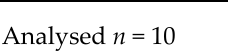
Figure 3. The CONSORT flow chart diagram for the trial.